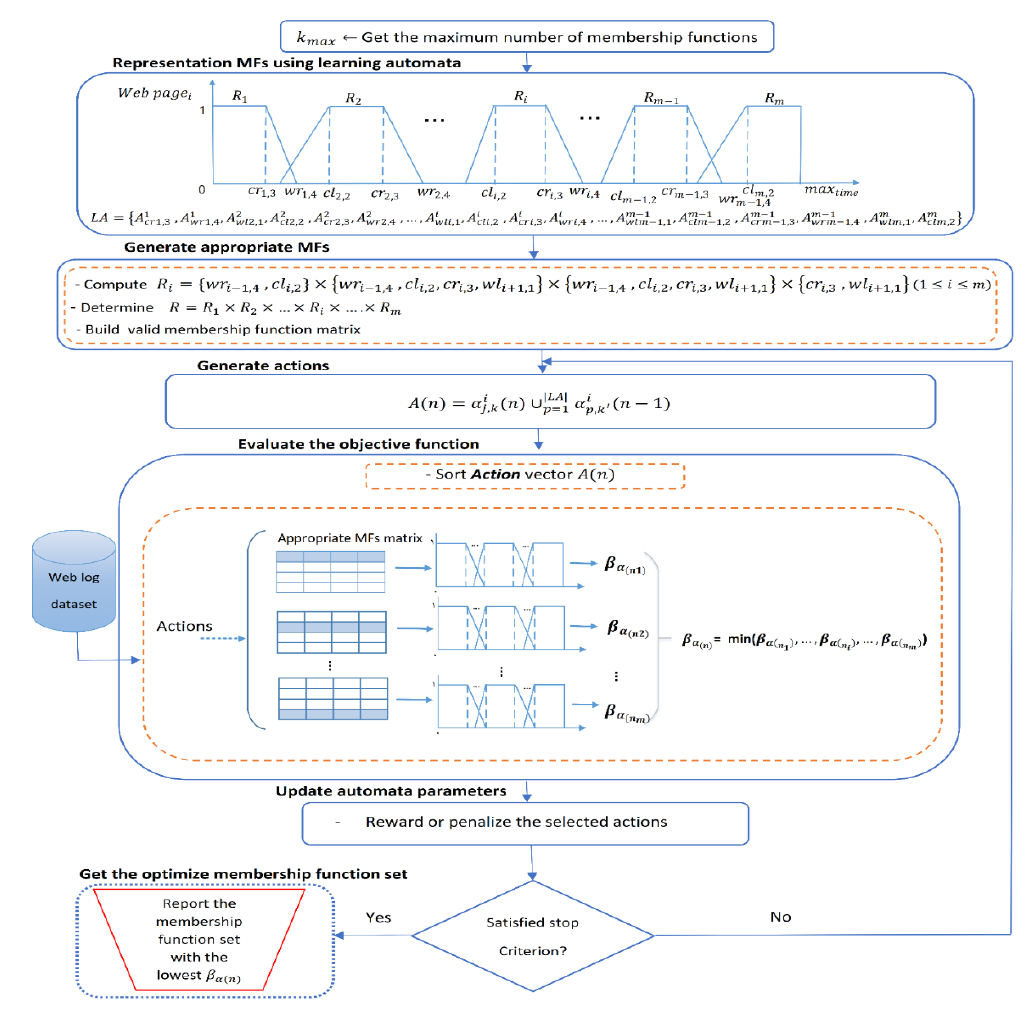
Figure 4. The proposed framework.